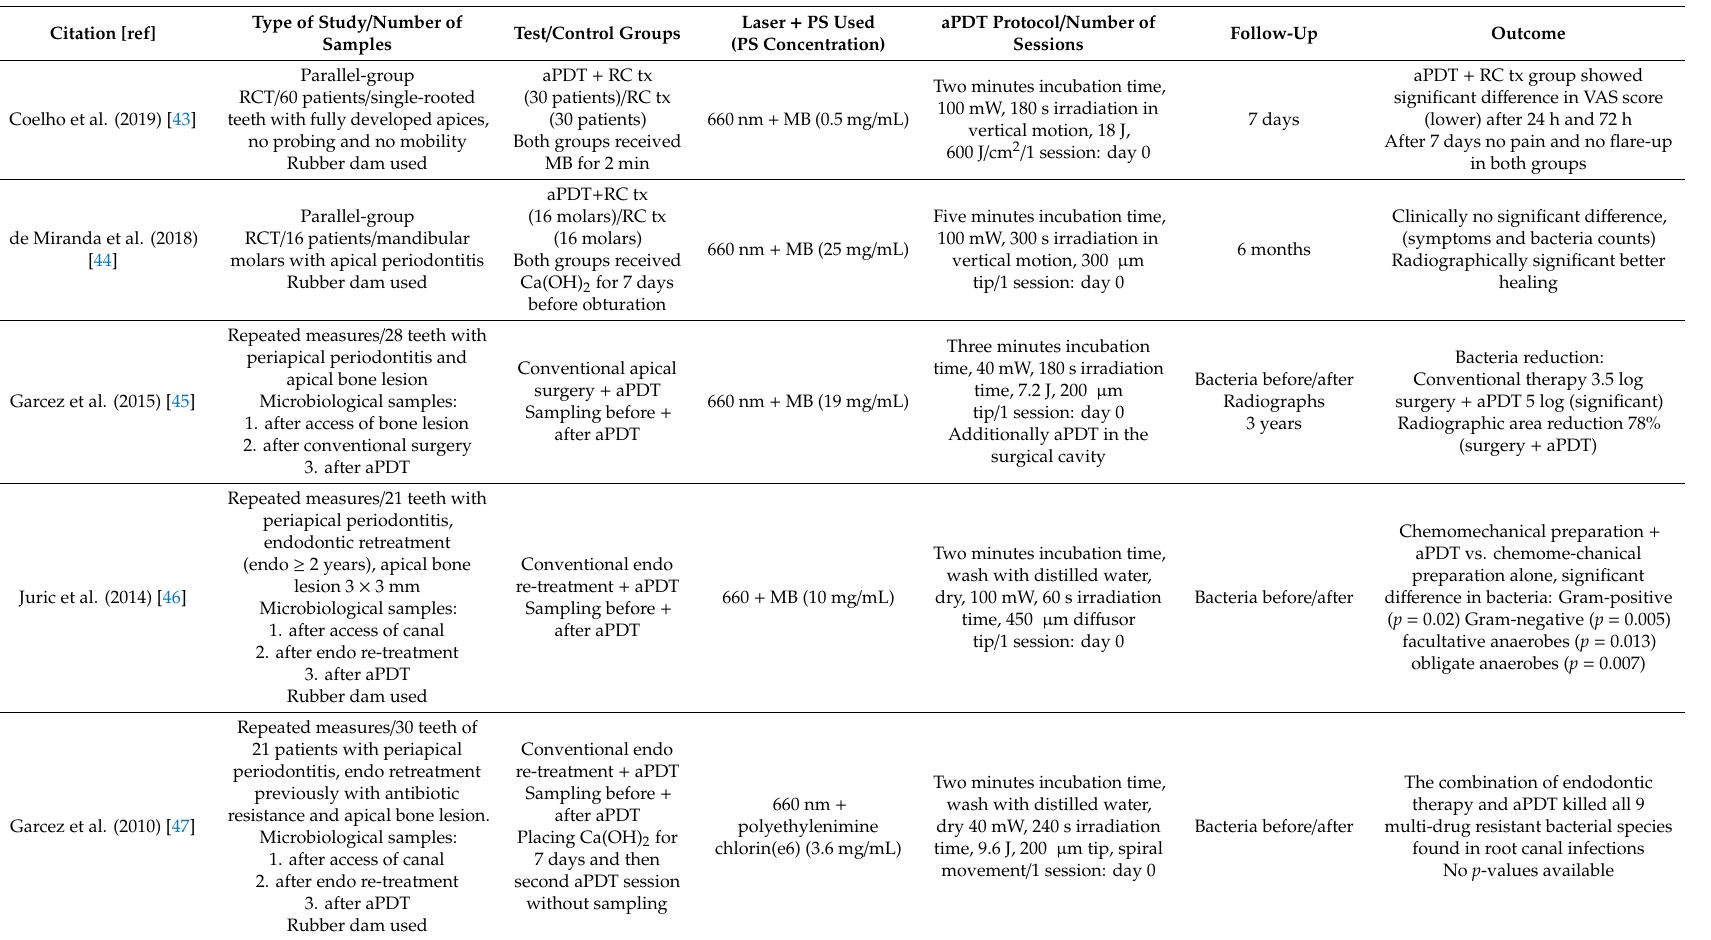
Table 3. Studies of aPDT in